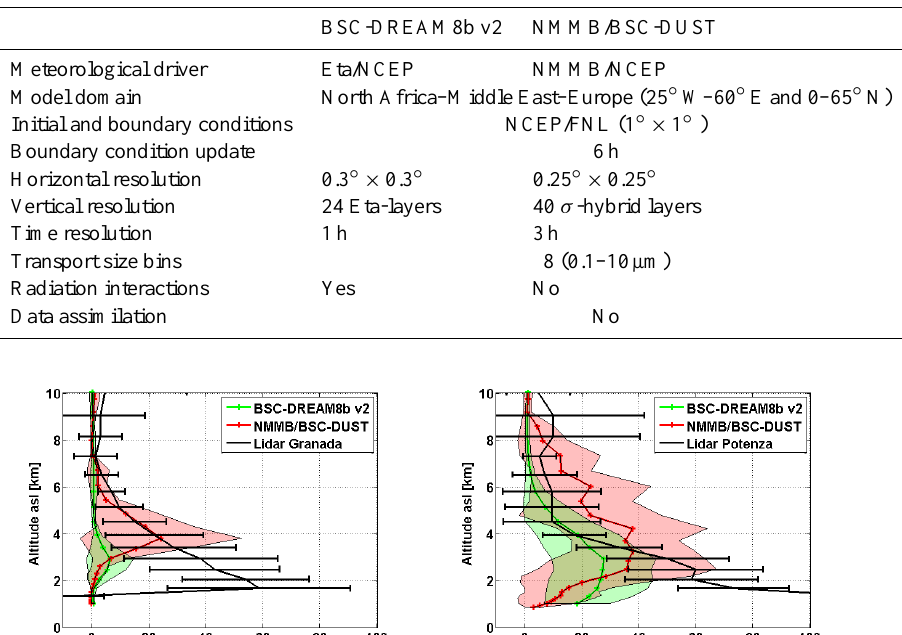
Table 4. Main parameters of the dust transport models used in this study.